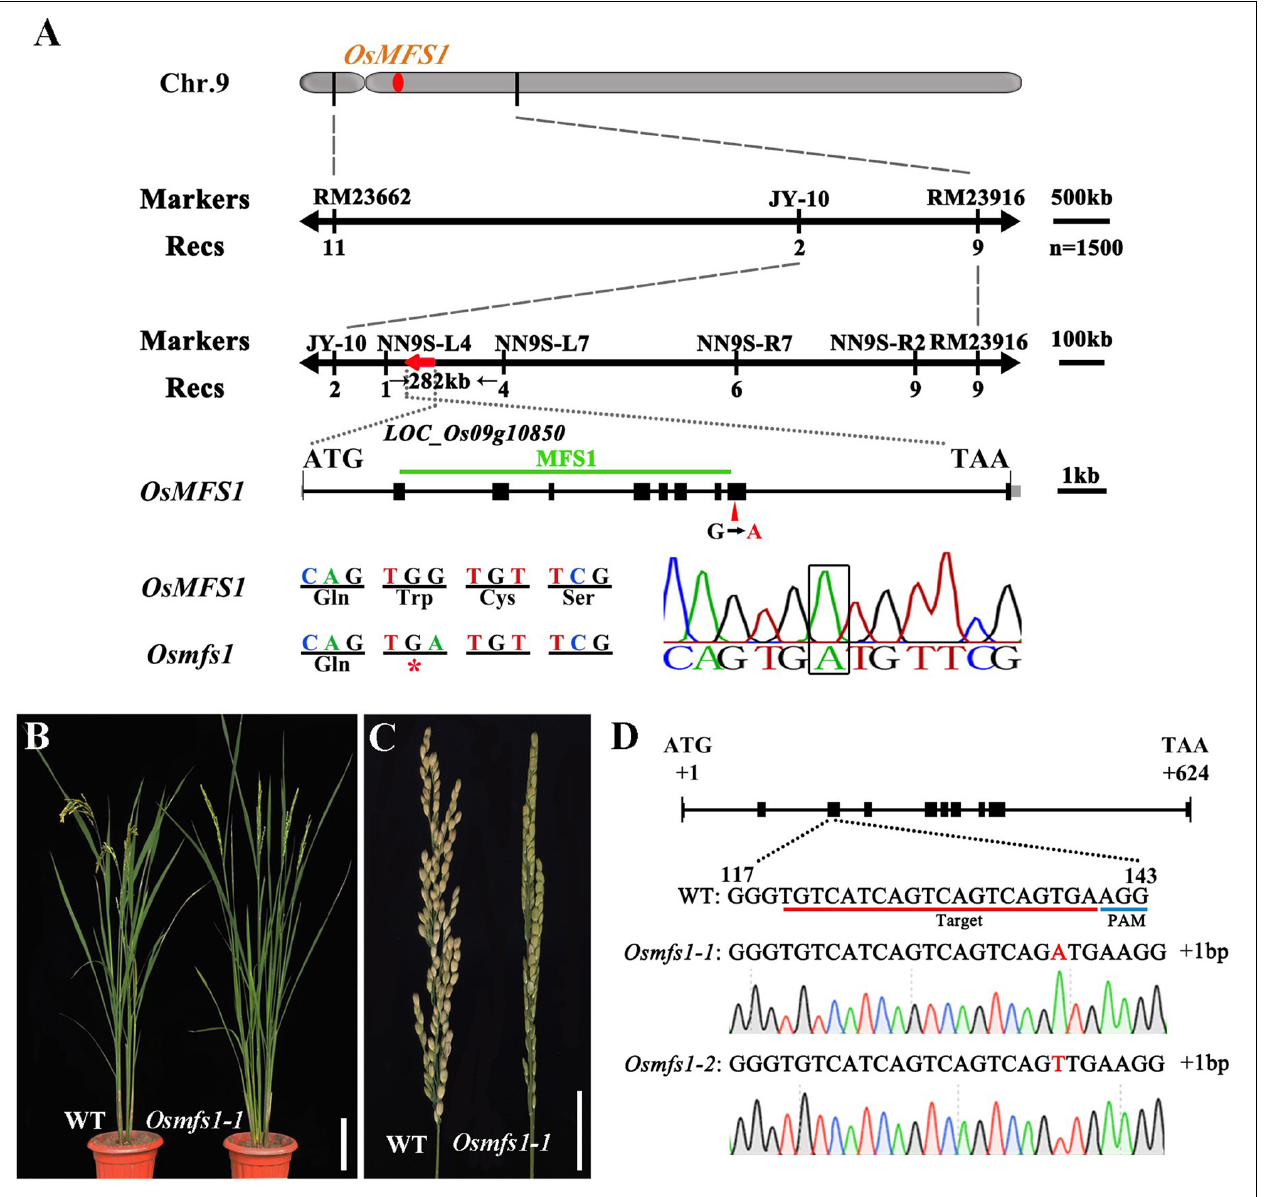
FIGURE 6 | Map-based cloning of the OsMFS1 gene and phenotype comparisons between the WT and the Osmfs1 mutant (The positive T 3 plants of CRISPR/Cas9). (A) Primary mapping was performed using markers RM23662 and RM23916 on chromosome 9, and further fine-mapped to a 282-kb genomic region between the markers NN9S-L4 and NN9S-L7, the OsMFS1 gene was located in the region. (B) Comparison between a WT plant (left) and a positive plant of Osmfs1 (right) at the heading stage. Bars = 10 cm. (C) Comparison between a panicle of WT (left) and a panicle of Osmfs1 (right) at the harvest stage. Bars = 2 cm. (D) A schematic representation of the gene structure of OsMFS1 , two lines with different mutation types were obtained, the sequences of both Osmfs1-1 and Osmfs1-2 have a single nucleotide insertion.